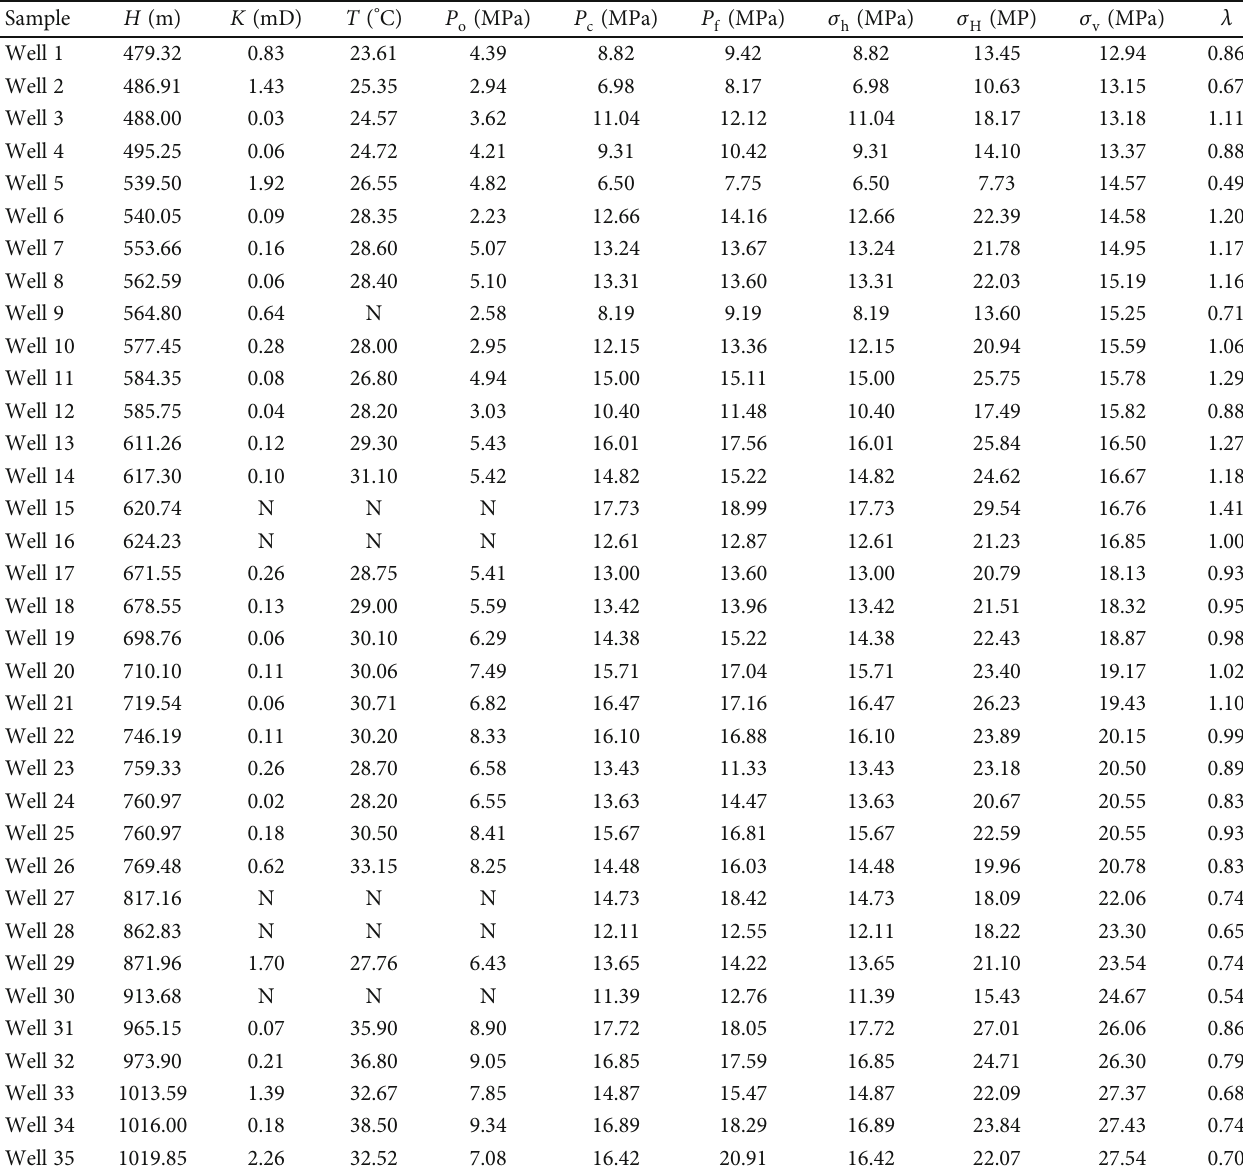
Table 1: Injection/fallo ff and in situ stress test parameters in the Liulin